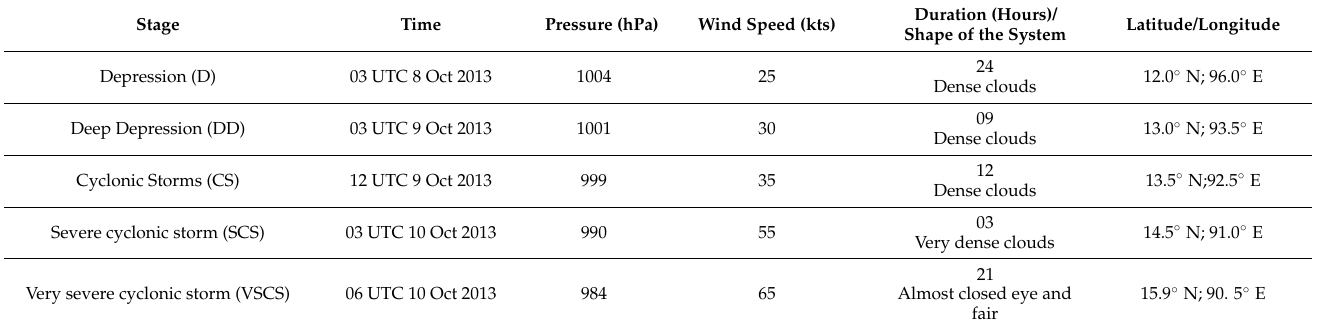
Table 1. Synoptic conditions of Phailin during 8–13 October 2013 obtained from IMD report. Stage Time Pressure (hPa) Wind Speed